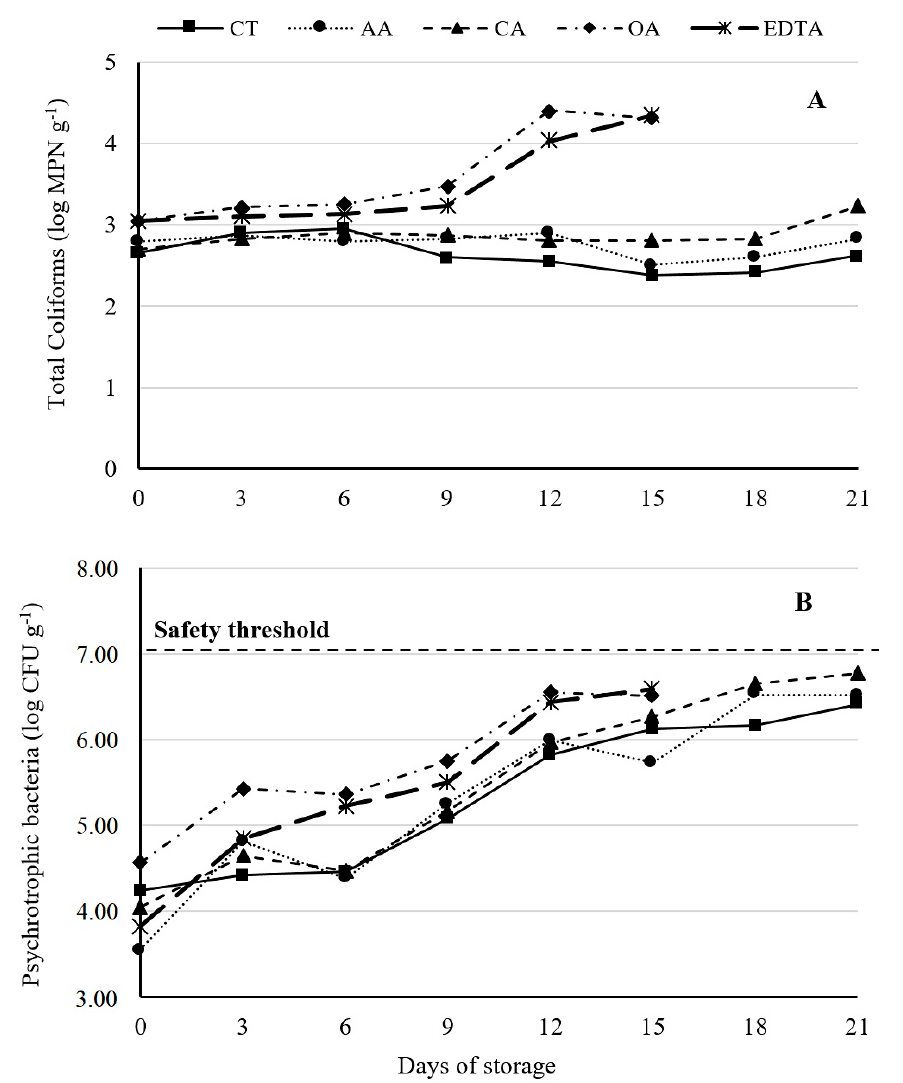
Figure 5. Total coliforms (log MPN g − 1 ) ( A ) and psychrotrophic bacteria (log CFU g − 1 ) ( B ) in leaves of minimally-processed escarole treated with different antioxidants and stored at 0 °C and 90–95% relative humidity for 21 days. CT: control; AA: 1% ascorbic acid; CA: 1% citric acid; OA: 1% oxalic acid; and 2% EDTA: ethylenediaminetetraacetic acid.